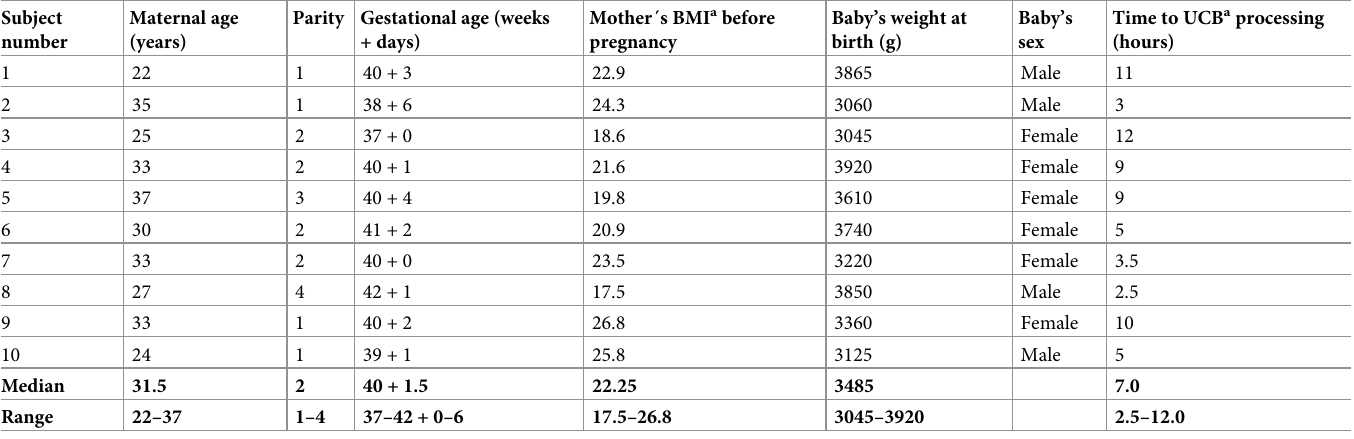
Table 1. Characteristics of the 10 mothers and respective neonates, as well as storage time of umbilical cord blood from collection at delivery until isolation of UBMC a